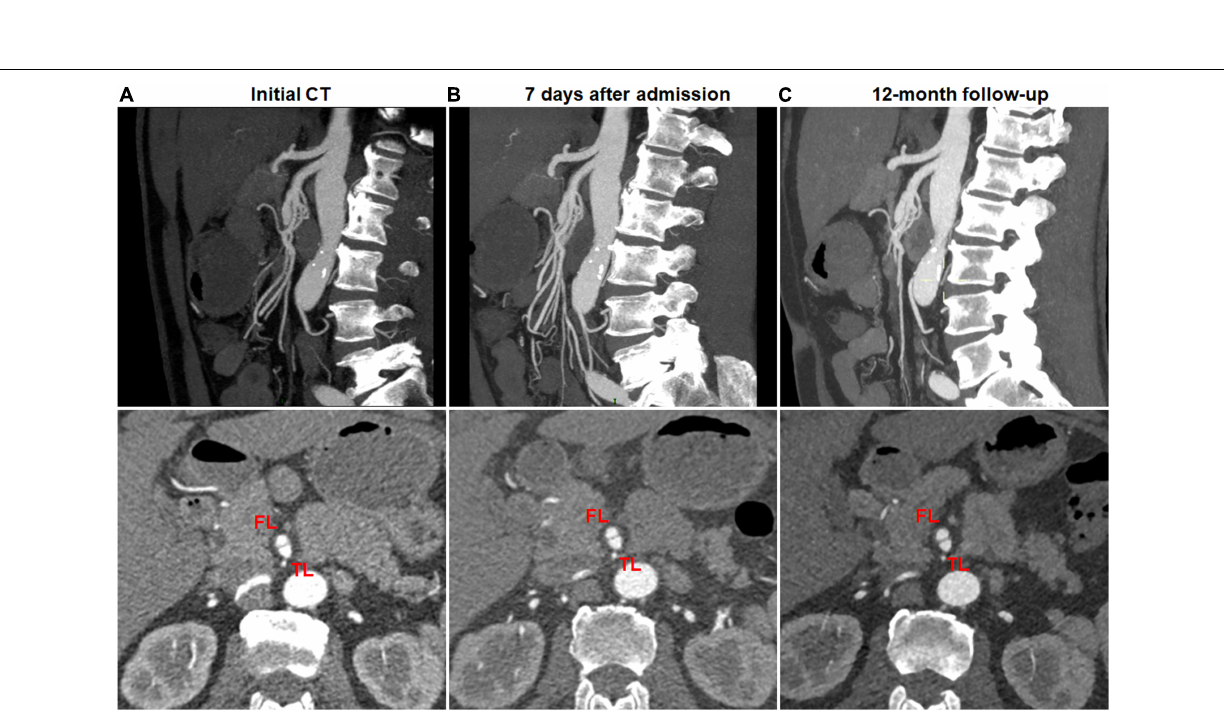
Frontiers in Cardiovascular Medicine |